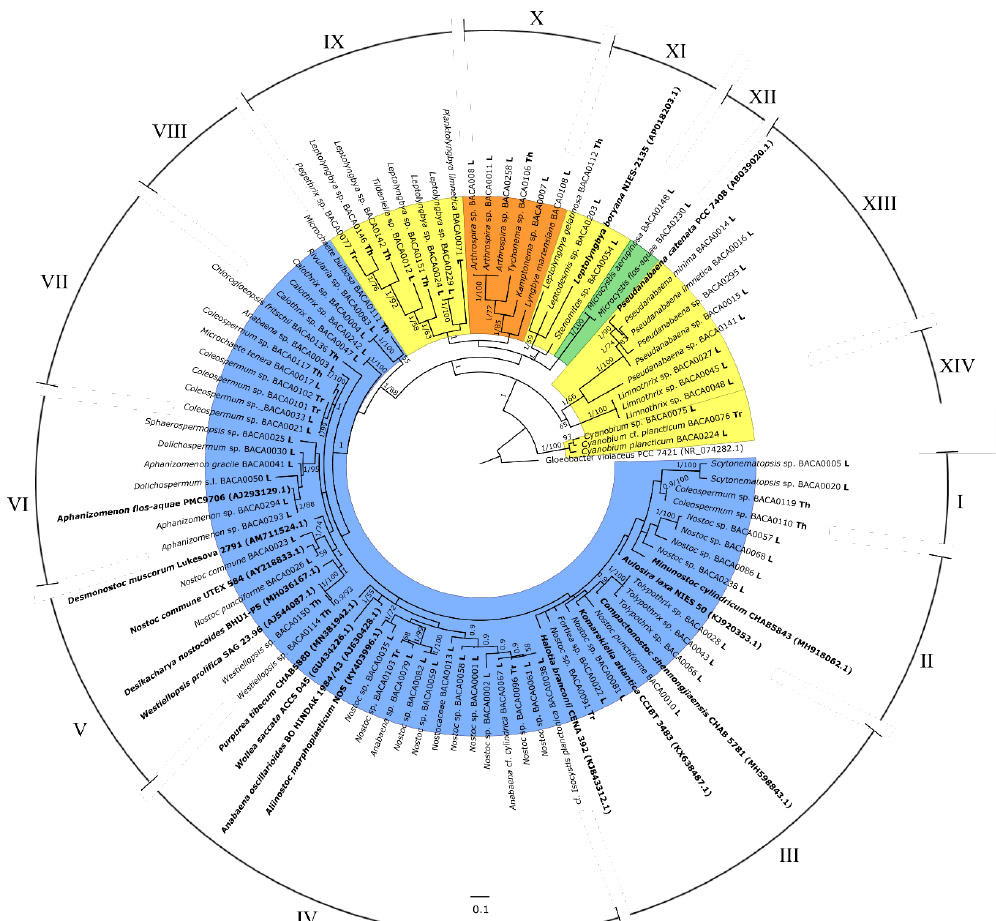
Figure 2. Bayesian inference phylogenetic tree based on the partial 16S rRNA gene sequences. A bootstrap test involving 1000 pseudo-replicates was performed. Bootstrap (greater than 50%) and probabilities values (greater than 0.9) are displayed in front of the relevant nodes obtained from ML and Bayesian methods, respectively. Colors represent cyanobacteria orders: Nostocales (blue), Synechococcales (yellow), Oscillatoriales (orange), and Chroococcales (green). The 14 identified clusters (I–XIV) are indicated along the tree and described in the text. L: lake, S: stream, Tr: terrestrial; Th: thermal.